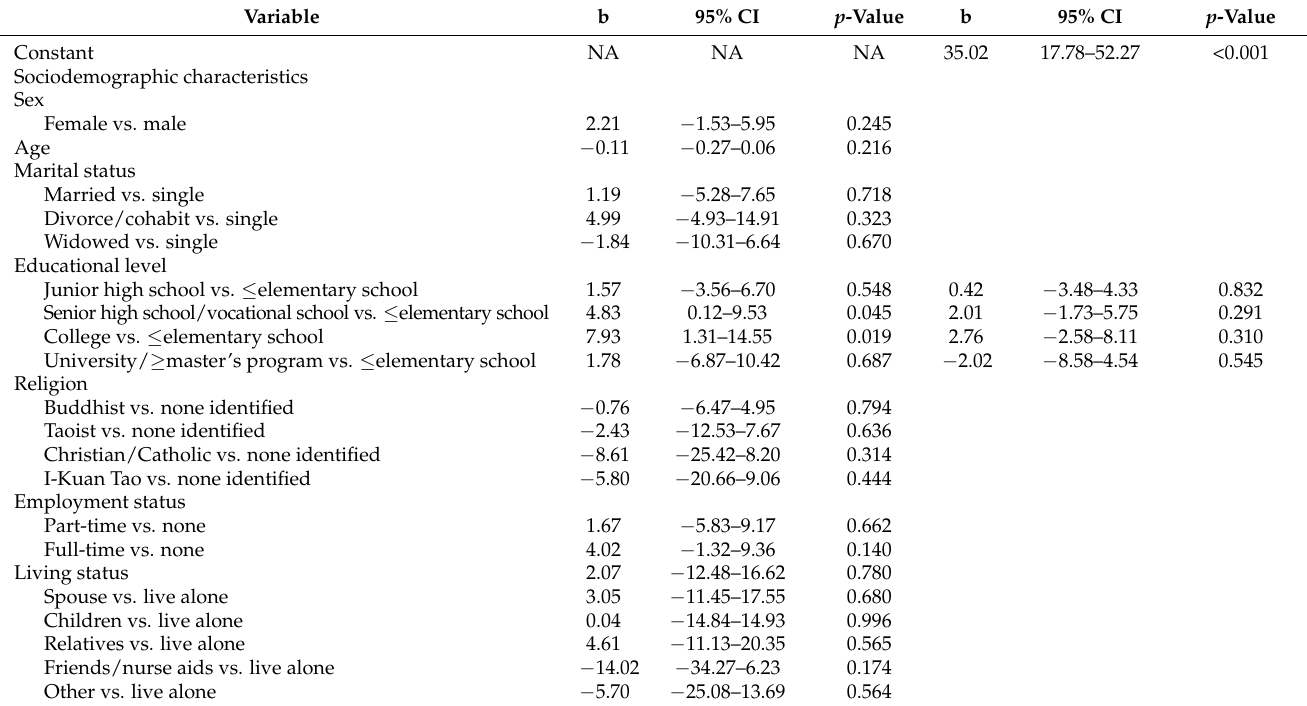
Table A1. Factors related to quality of life of hemodialysis patients in bivariate and multivariate linear regression (n =